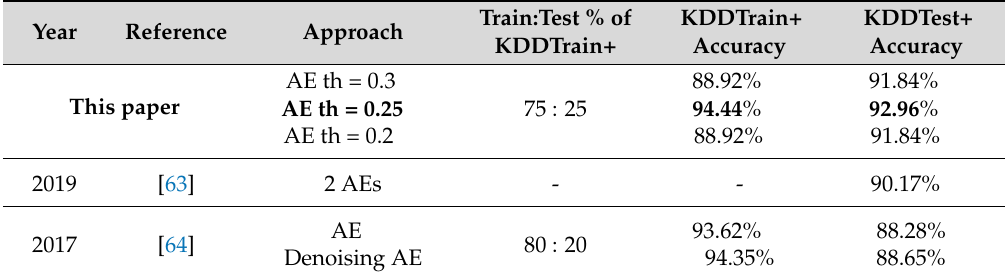
Table 4. NSL-KDD Performance Comparison with Recent Literature. (Highest accuracy in Bold ).